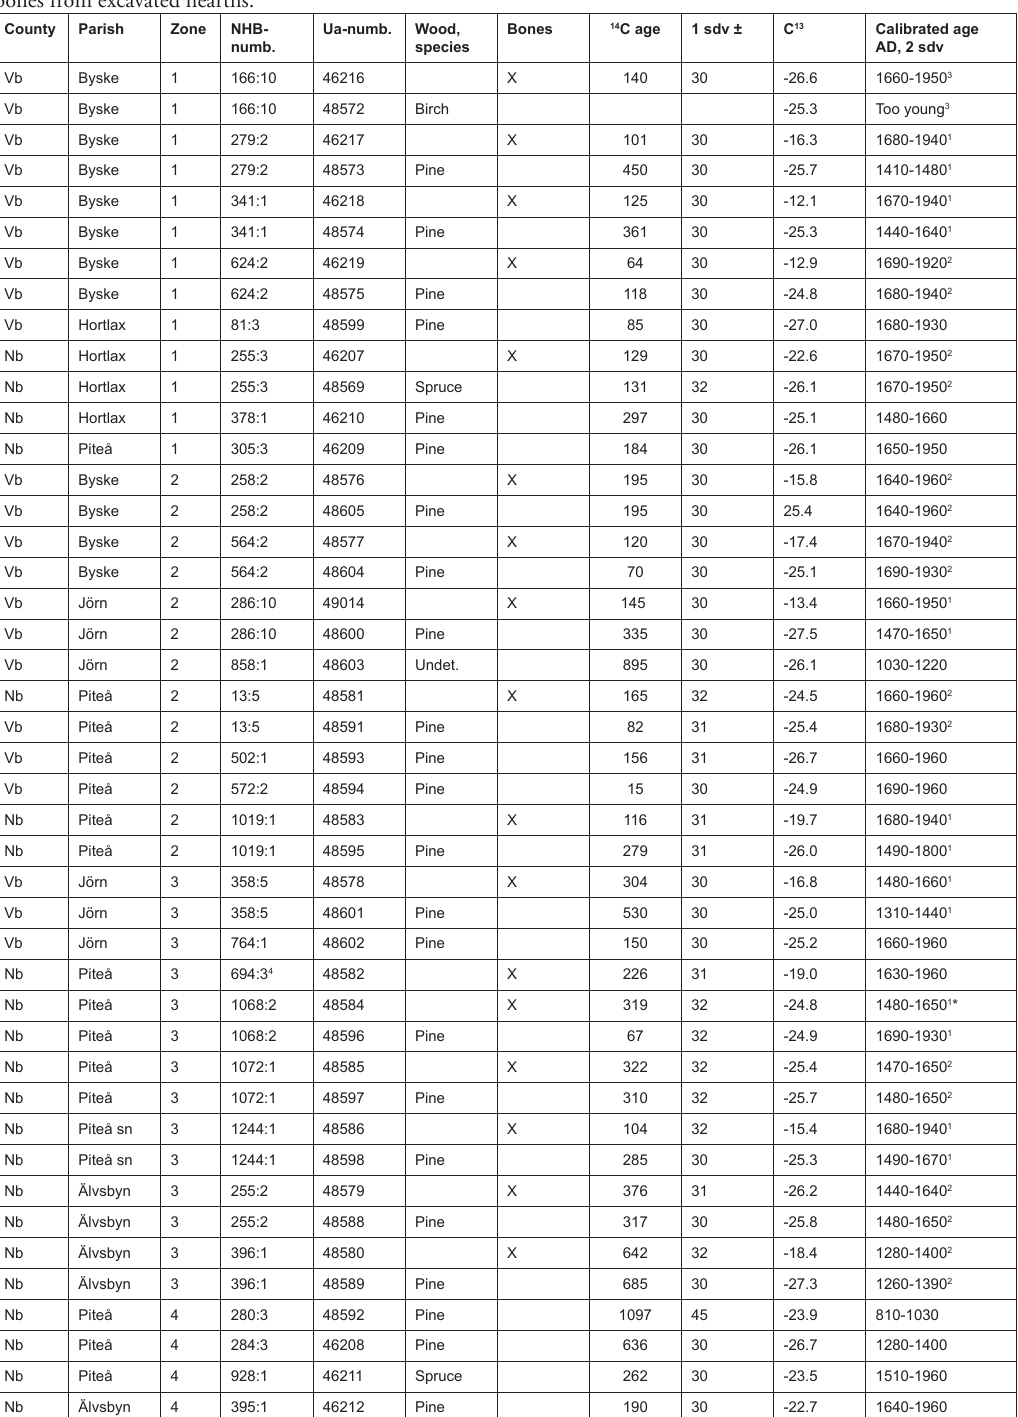
Table 3. AMS-datings made by the Ångström Laboratory in Uppsala, Sweden. Datings made on charred wood and bones from excavated